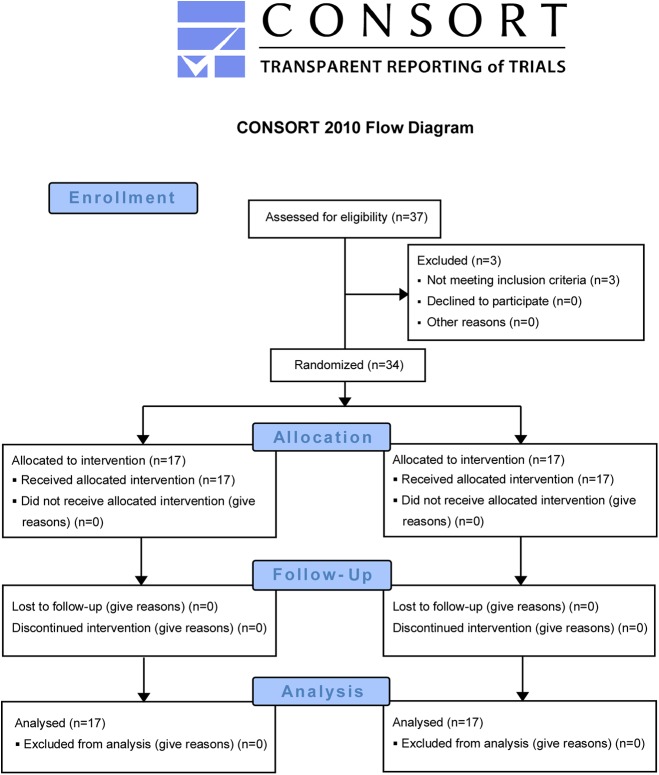
CONSORT flow chart.